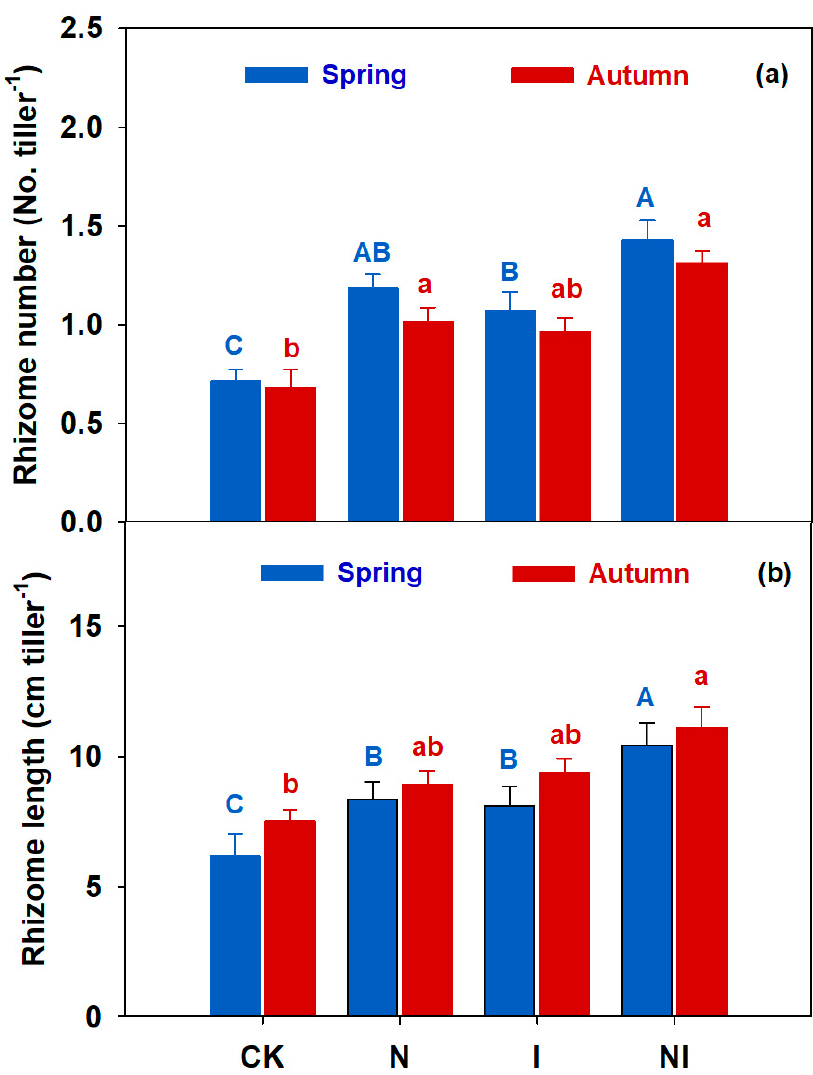
Figure 4. Different treatment effects on the rhizome number ( a ) and rhizome length ( b ) in different seasons. For each independent variable, different lowercase letters or capital letters indicate significant differences between the four treatments in the same season. Shown are the means ± 1 SE ( n = 4). Different letters denote a p < 0.05 difference based on an LSD post hoc multiple comparison test. (CK, control; N, nitrogen application; I, irrigation; NI, irrigation and nitrogen application).